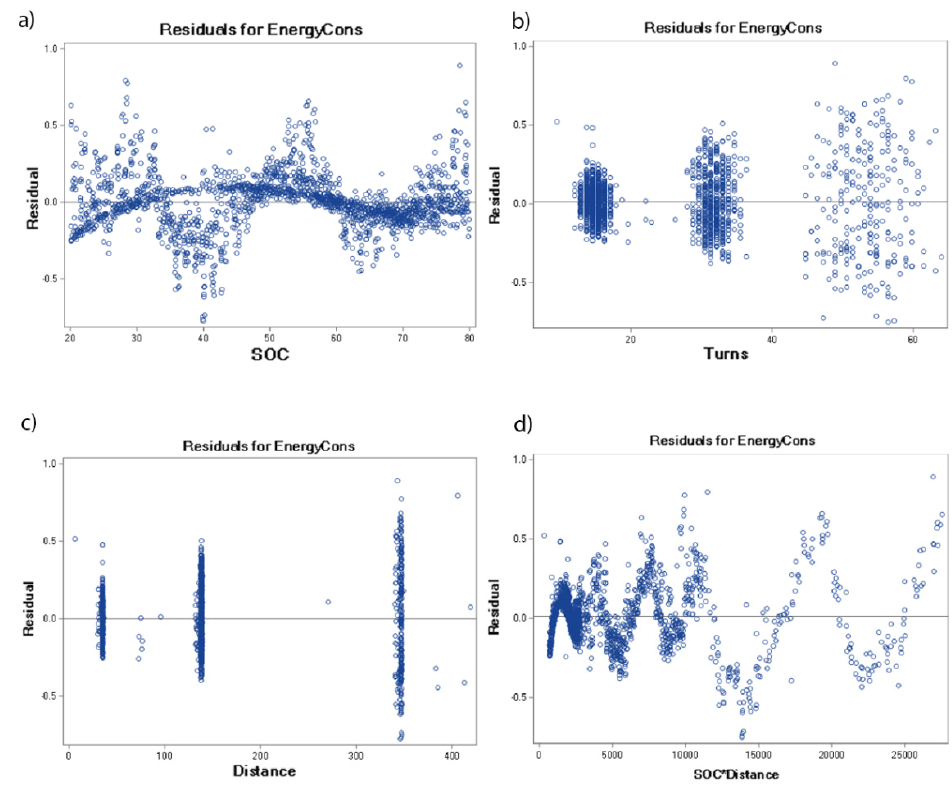
Figure 7. Residuals for selected effects of the tested battery from 2020.